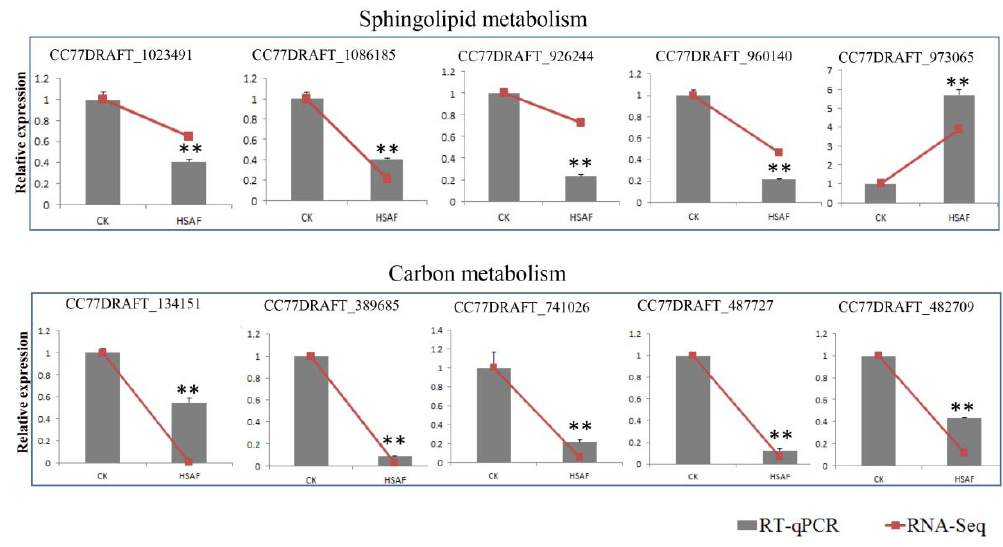
Figure 10. RT ‐ qPCR validations for genes participating in sphingolipid and nitrogen metabolism. The ten genes were using for RT ‐ qPCR analyses. Columns indicate the relative expressions of genes were tested by the RT ‐ qPCR, and linear graphs show the mean relative expressions data of genes that were predicted by RNA ‐ seq. The graph showed 5 genes’ expression levels under HSAF treatment, and 5 genes’ relative expression is shown on the graph below. Relative expression of each gene was analyzed by RT ‐ qPCR, normalized to actin expression levels and the relative expression ratio was calculated as the fold change (2 −ΔΔ C t ) compared to the wild type (**, p < 0.01, t ‐ test). The relative expression levels of genes in RNA ‐ seq were calculated using “CK: the mean RPKM (CK) value/the mean RPKM (CK) value or HSAF: the mean RPKM (HSAF) value/the mean RPKM (CK) value”. The mean relative expression levels of three replicates from RT ‐ qPCR analyses were used for drawing graph. Each experiment was repeated at least three times.